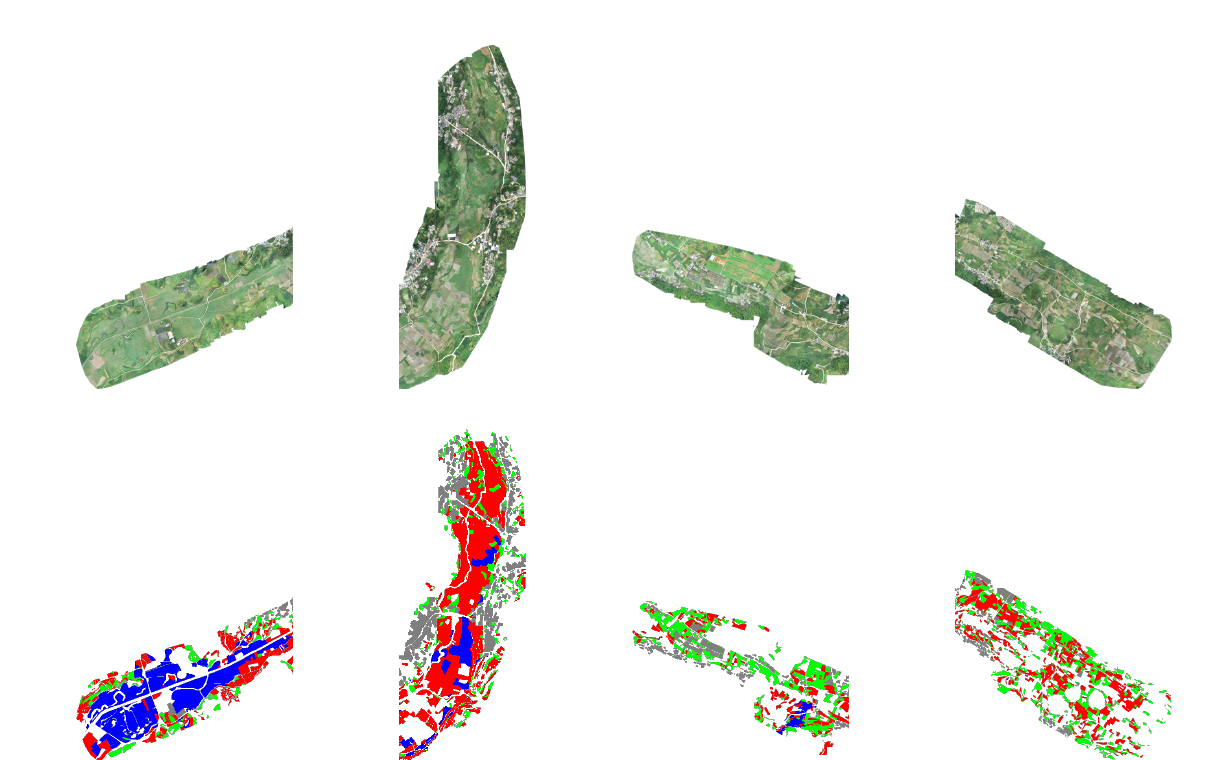
Figure 4. A panoramic view of the dataset. The top row is the RGB UAV remote sensing image, and the bottom row is the corresponding label.